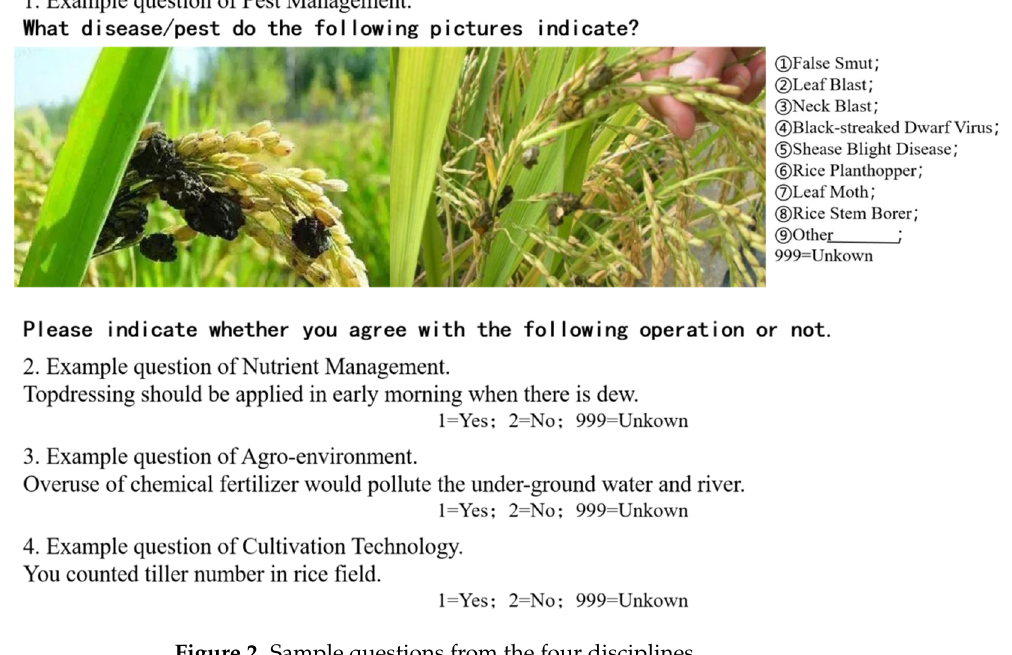
Figure 2. Sample questions from the four disciplines.